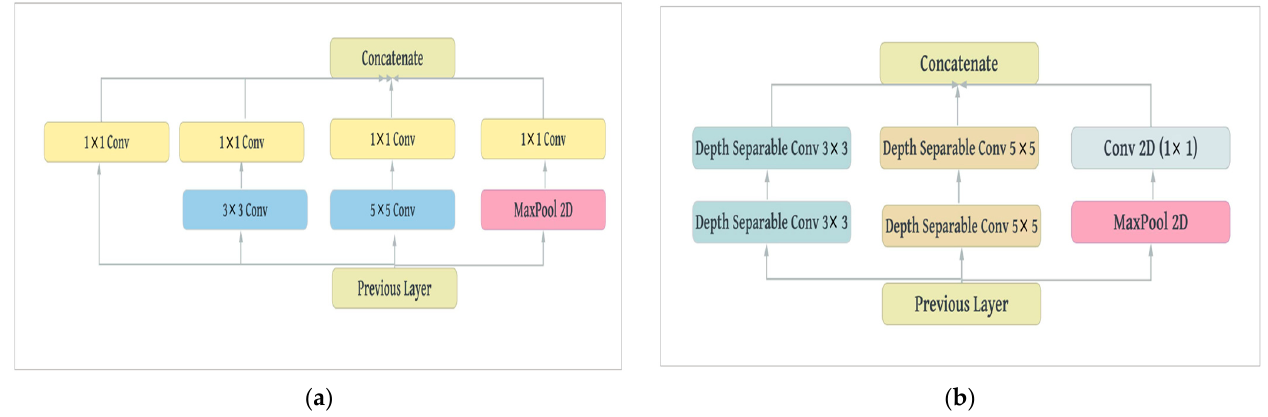
Figure 2. ( a ) Inception block; and ( b ) Block A is the proposed depth-separable block. The